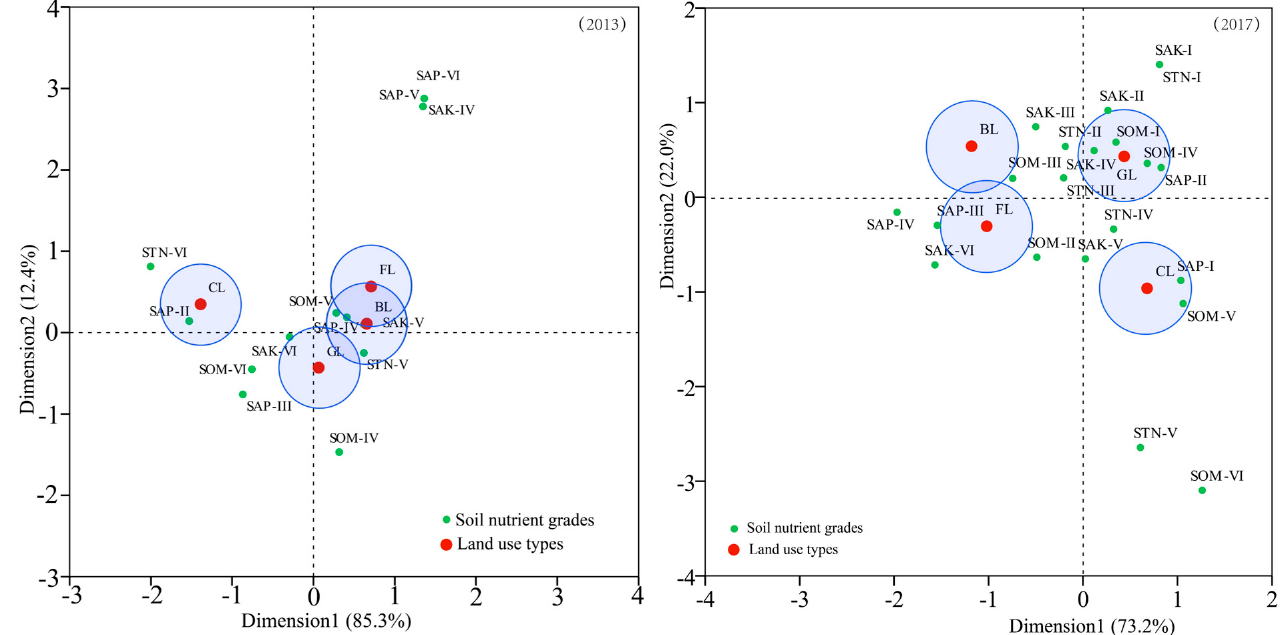
Figure 6. Correspondence analysis maps between land-use types and soil nutrient grades (CL. Cultivated land; GL. Grassland; FL. Forestland; and BL. Barren land).